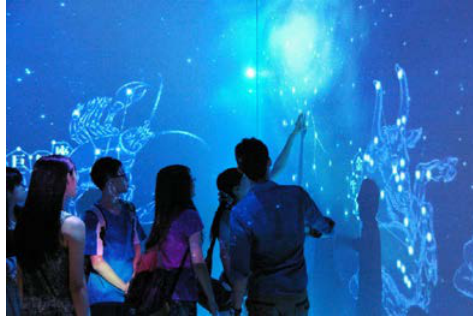
Figure 5. Participants interact in scenario 3: call out the 12 zodiac signs by waving arms.